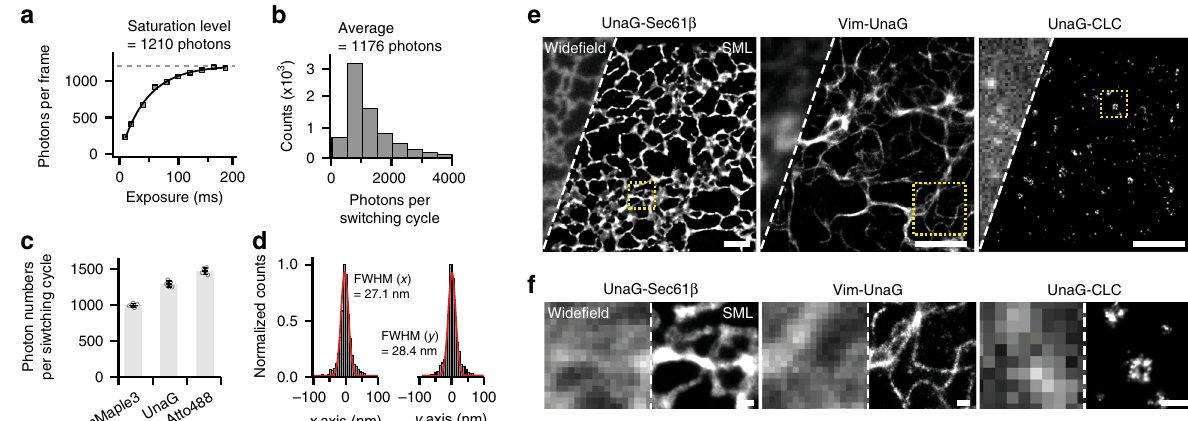
Fig. 4 Applications to super-resolution microscopy of UnaG. a Averaged photon numbers per frame from single holoUnaG as increasing the camera exposure time. b Distribution of photon counts per single switching event at 180 ms exposure time. c Comparison of the photon numbers per switching cycle for conventional super-resolution probes measured in an identical experimental setup, with 200 ms of camera exposure time. High illumination powers at 561 nm (mMaple3) or 488 nm (UnaG and Atto 488) were used so that most of the single fl uorophores switched off in a single camera frame. As a result, UnaG gave more than 1200 photons, which stands between the mMaple3 and Atto 488. d Repetitive localization positions measured from surface-immobilized single UnaG molecules, projected in x axis and y axis in the lateral directions. Multiple localization distributions were aligned by their centroid positions obtained from Gaussian fi ts. The combined datasets were again fi tted with Gaussian that yielded ~12 nm of localization precision and ~28 nm of full-width at half-maximum (FWHM) in lateral planes. The localization distributions were normalized by their own maximum counts. e Demonstration of SML imaging utilizing the photo-switchable nature of holoUnaG in various subcellular structures (left: ER, middle: vimentin fi laments, right: clathrin-coated pits) in fi xed Cos7 cells. f Close-up wide fi eld and SML images from the yellow-boxed regions in e . Scale bars: 2 µ m for e ; 200 nm for f . Error bars: standard deviations ( n = 5, each measurement contained more than 500 single-molecule information). CLC clathrin light